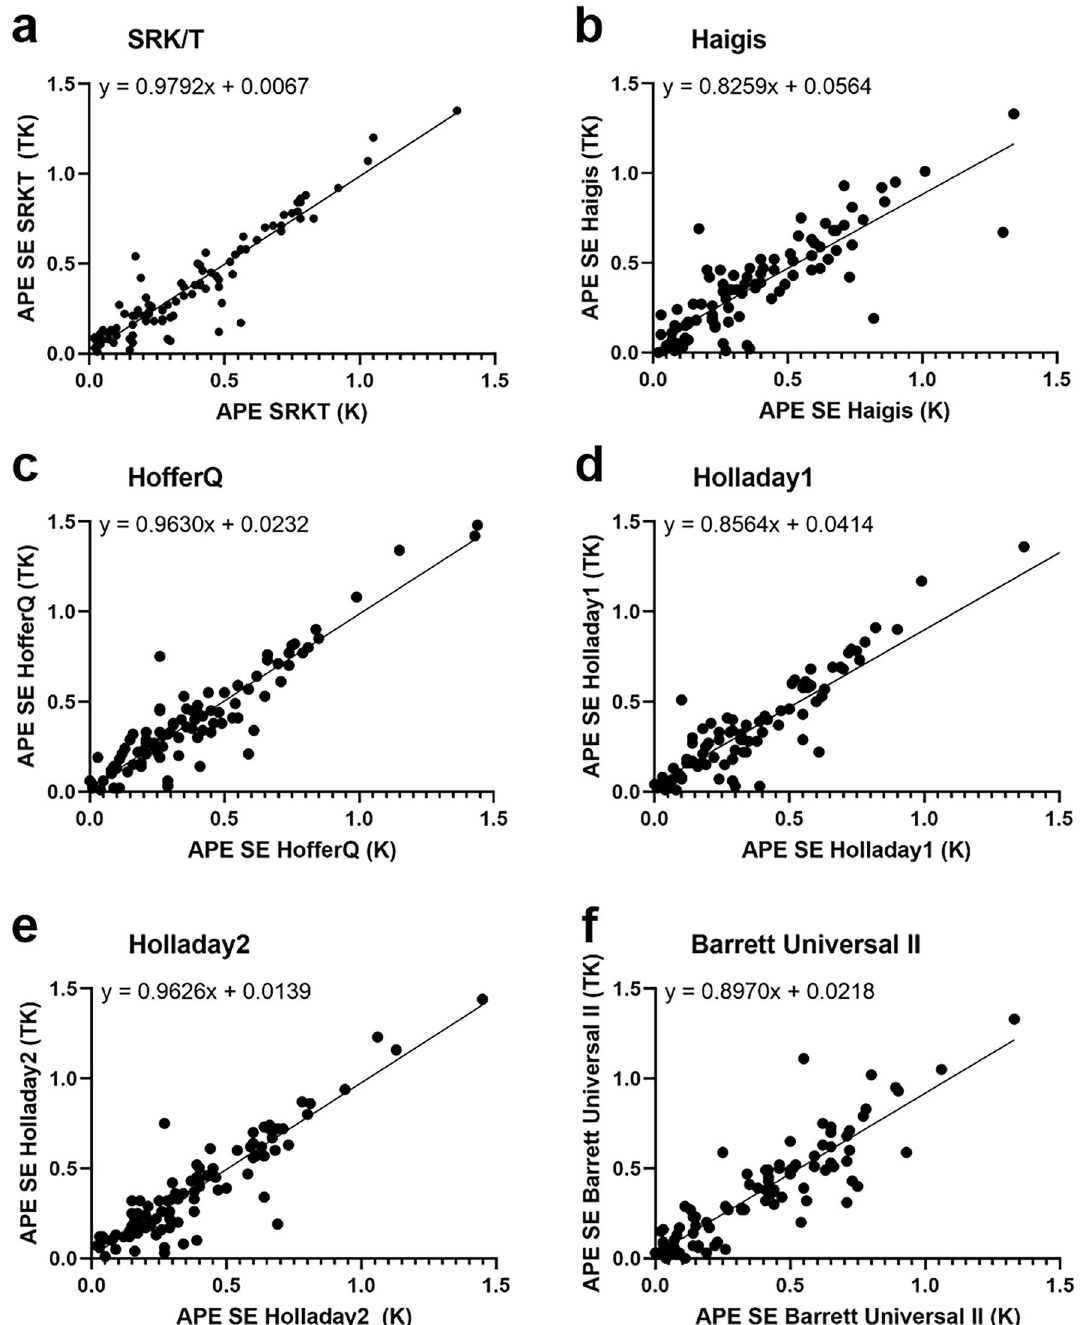
Figure 2. Pairwise comparison of absolute prediction error (APE) of spherical equivalent (SE) from standard keratometry (K) and total keratometry (TK) values. ( a ) APE of SE calculated using the SRK/T formula. ( b ) APE of SE calculated using the Haigis formula. ( c ) APE of SE calculated using the Hoffer-Q formula. ( d ) APE of SE calculated using the Holladay 1 formula. ( e ) APE of SE calculated using the Holladay 2 formula. ( f ) APE of SE calculated using the Barrett Universal II